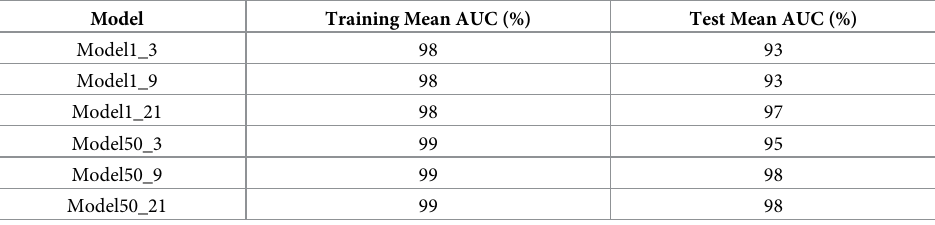
Training and test AUC values (mean) described the model performance during model development and validation.